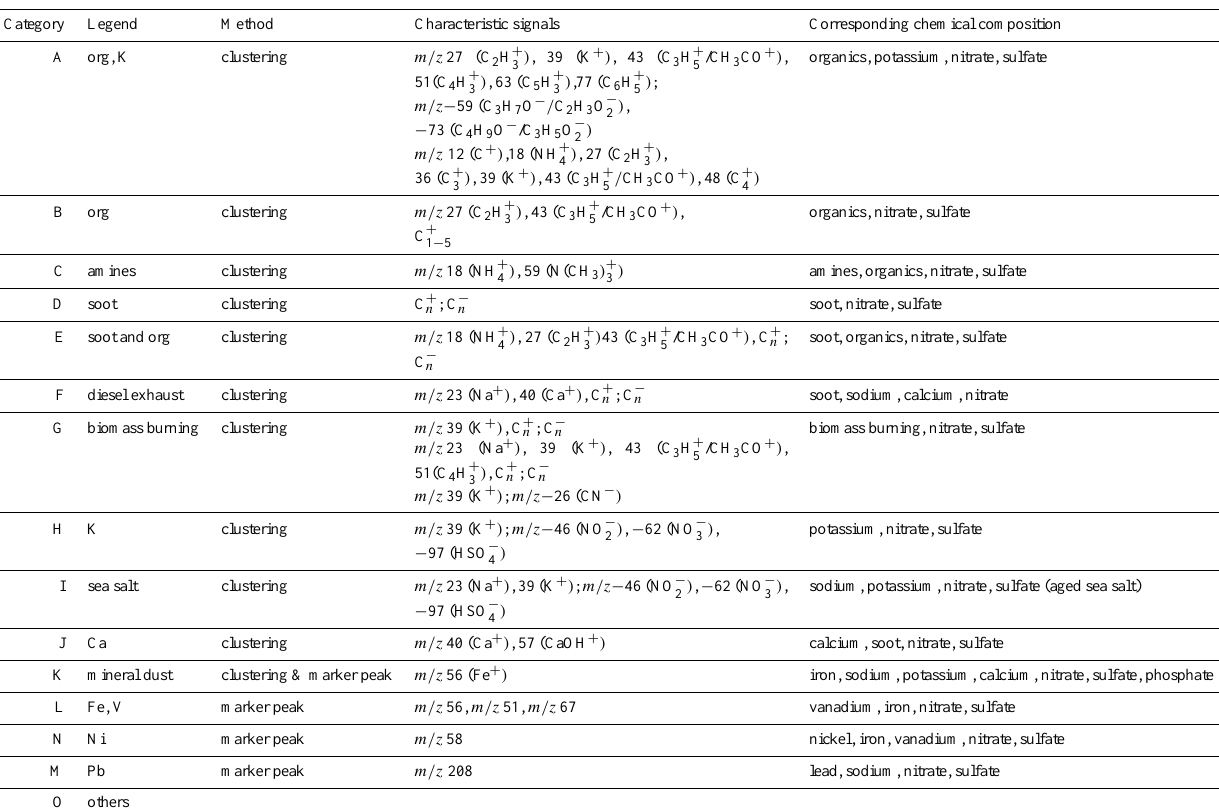
Table 3. Overview of identified particle types and the characteristic peaks used for the assignment of clusters to a particle type. Additionally the observed chemical composition of the particle types and the denotation used in the following (legend) are listed. Secondary inorganic compounds like nitrate and sulfate were present in every particle type and have therefore not been used as characteristic signals for the separation of particle